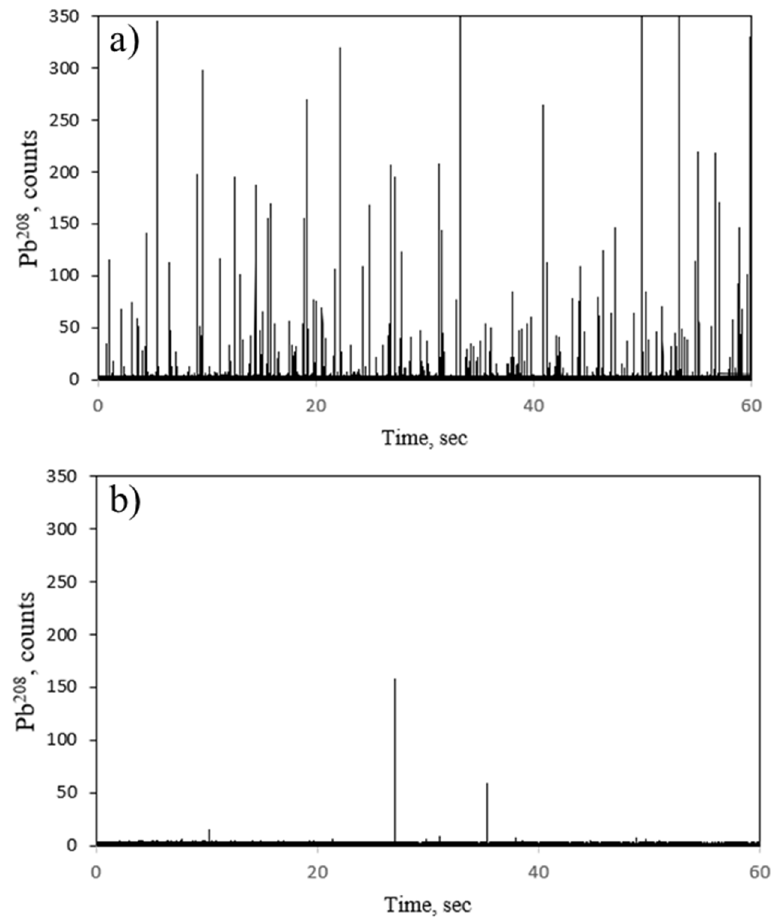
Figure 4. ( a ) Mixture of PSAA22 and Lead (II) phthalocyanine ( b ) Lead phthalocyanine in water in the absence of PSAA22; after centrifugation.